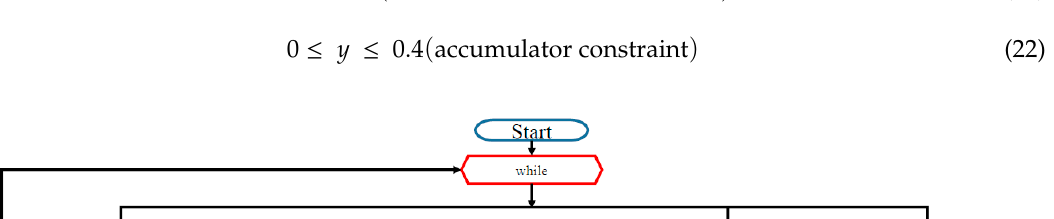
8 of 17 Table 1. Parameter settings of genetic algorithm (GA). Gene Length